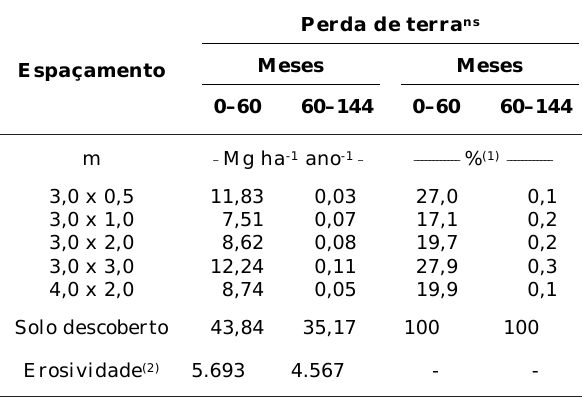
(1) Percentagem em relação ao solo descoberto. (2) MJ mm ha -1 h -1 ano -1 . ns diferença, entre os tratamentos, não-significativa pelo teste Duncan ( a =